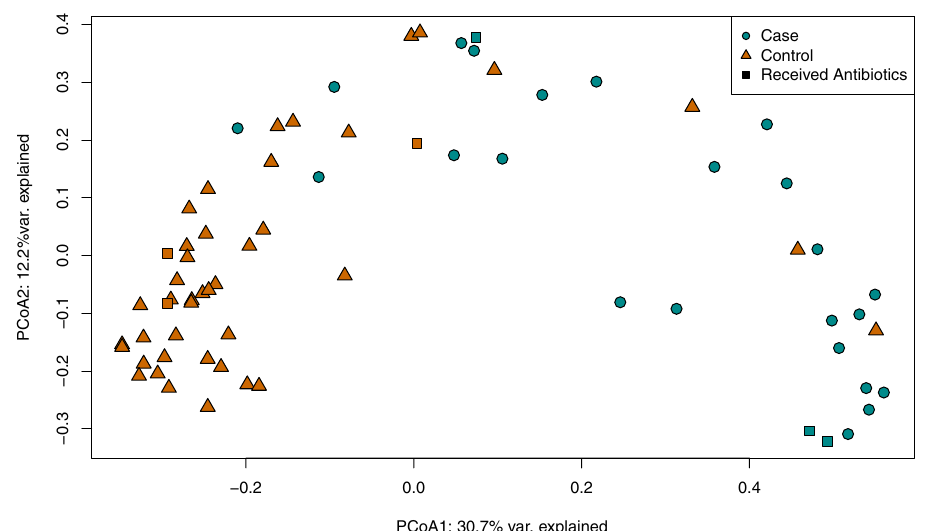
Figure 2. Resistomes of cases and controls are distinct. Principal Coordinates Analysis (PCoA) plot of case (cyan, circles) and control (orange, triangles) resistomes based on Bray–Curtis dissimilarity. The first and second coordinate are shown with their respective percentage of explained variance. Patients that self-reported use of antibiotics two weeks prior to sample collection are indicated by square data